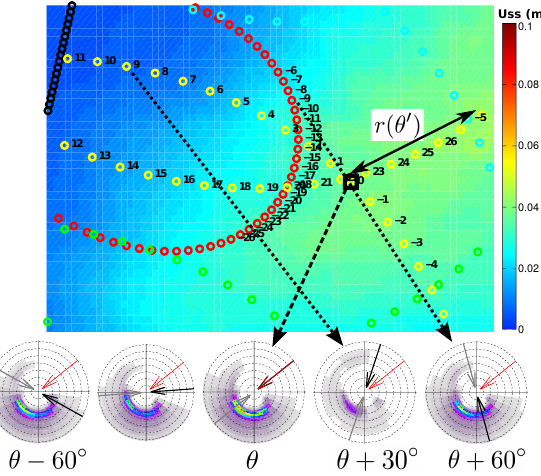
Figure A1. Illustration of the use of cycles in azimuth θ (cid:48) (circles) for the estimation of the wave bias U WB = GU S , R at the location (black square) of cycle with direction θ . The background color shows the magnitude of U S , and the bottom spectra are at the lo- cation of different cycles, with wave energy plotted in the direc- tion from which it arrives. In each spectra the red arrow is direc- tion θ , and the black and grey arrows show θ (cid:48) and θ (cid:48) + π . The dis- tance r(θ (cid:48) ) is a source of